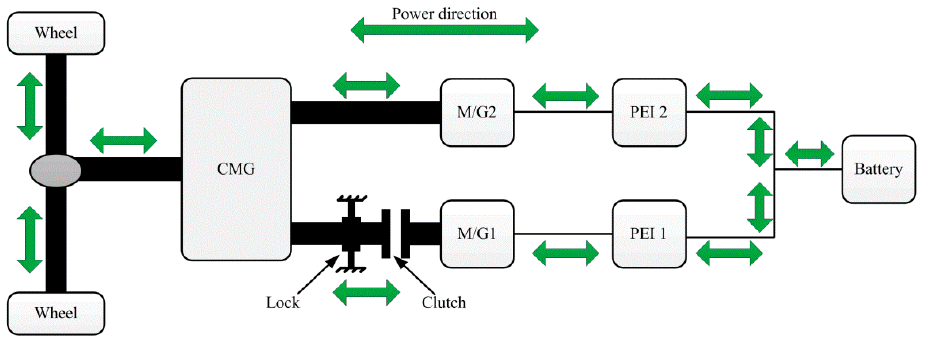
Figure 3. Power flow paths.